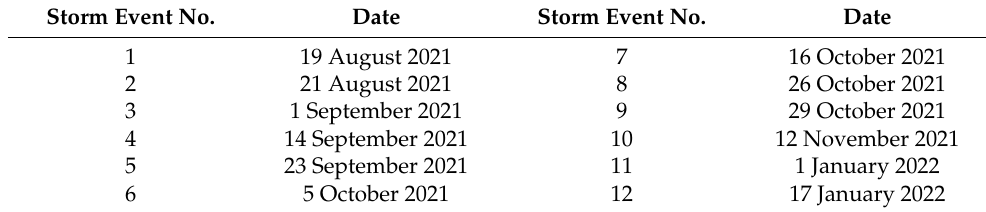
Table 1. Storm events monitored at the Stevens CPH parking lot. Storm Event